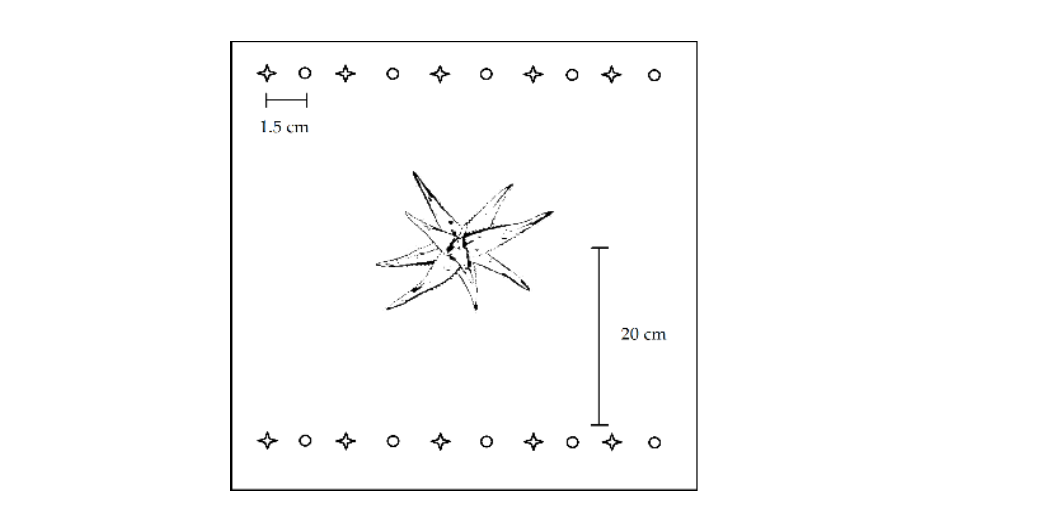
Figure 1. Schematic of seeding placement in a tray used in the pot experiment. Stars = Bermuda grass seeds, circles = African daisy seeds.